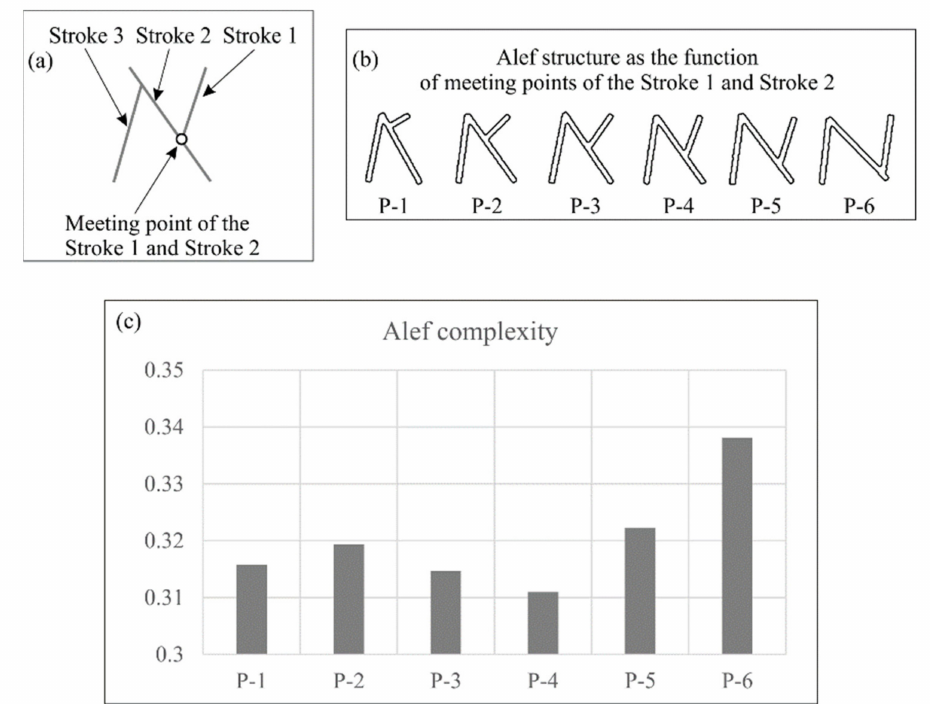
Figure 19. The influence of basic graphical elements on Alef’s complexity. ( a ) Basic graphical elements. ( b ) Shape of Alef as the function of basic graphical elements. ( c ) Alef’s complexity. Credit: Drawing by Dr. Ada Yardeni, courtesy of Carta Jerusalem